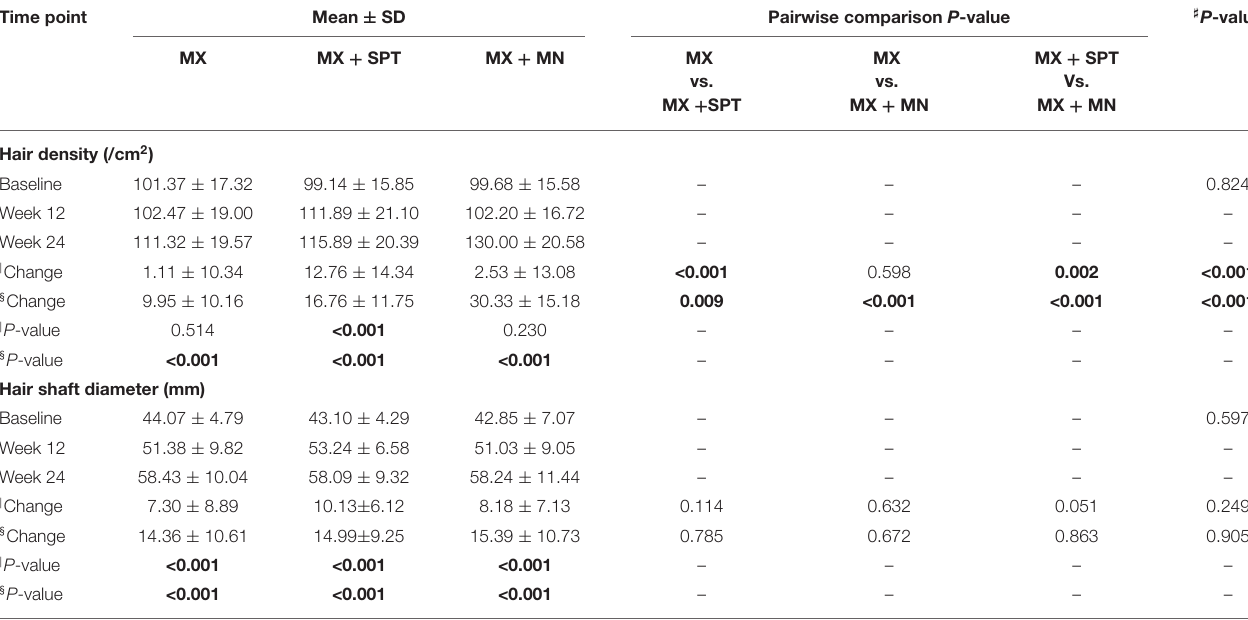
TABLE 2 | Dermoscopic assessment during the study period among the three groups. Time point Mean ± SD Pairwise comparison P